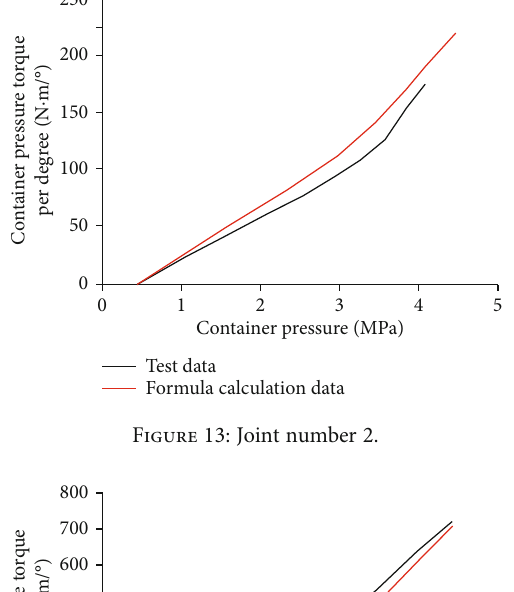
Figure 13: Joint number 2.